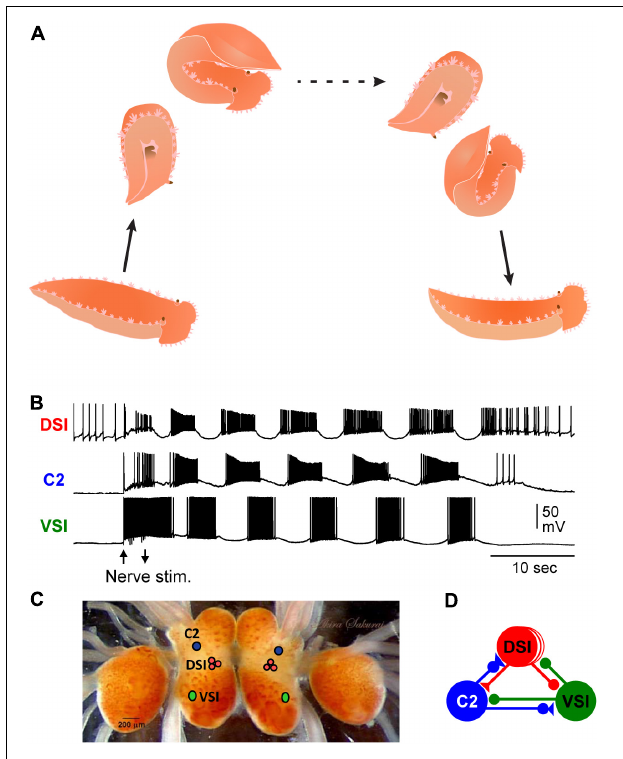
FIGURE 1 | Tritonia swimming behavior and swim motor pattern mechanism. (A) Illustration of Tritonia dorsal-ventral flexion swimming behavior. (B) Simultaneous intracellular recordings from identified neurons, DSI, C2, and VSI during a swim motor pattern elicited by stimulation of a body wall nerve (arrows). (C) A photograph of the dorsal side of the Tritonia brain, showing the locations of the swim interneurons (C2, DSI, and VSI). (D) A schematic diagram of the swim CPG. Triangles represent excitatory synapses, circles represent inhibitory synapses, and combined represent multicomponent